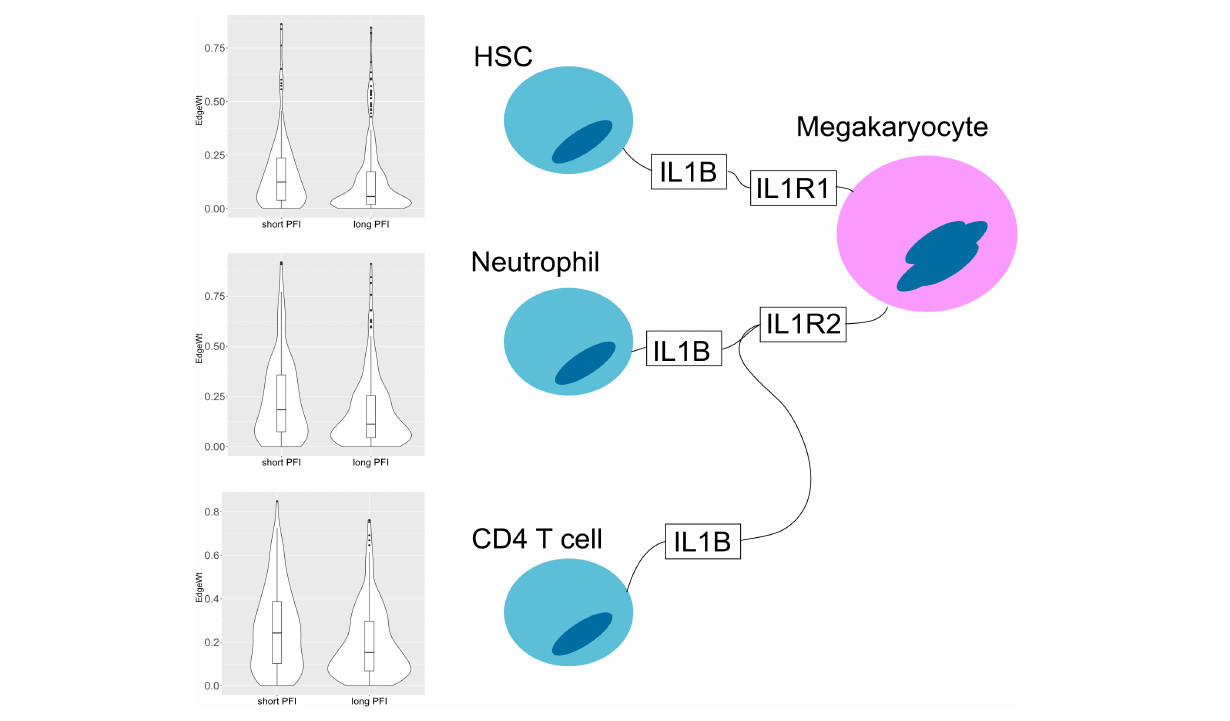
FIGURE 10 | Cell–cell interaction diagram demonstrating complexity in communication with three cell types that produce the IL1B ligand that have two possible binding partners on the same receptor bearing cell. Edge weight violin plots are shown for two STAD PFI groups, short (left) and long (right)